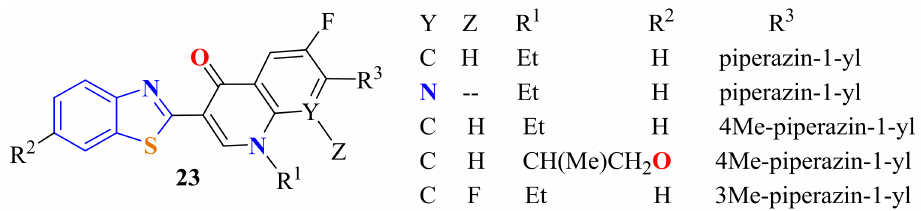
Figure 6. Naphthyridinebenzothiazoles from condensation reaction of substituted ATPs. The condensation reactions of 4-amidino-substituted ATPs with 2,5-furan- and 2,5- thiophene dicarboxylic acid were performed on heating in PPA at 180 ◦ C for 2 h. The yields (Scheme 12) [117].